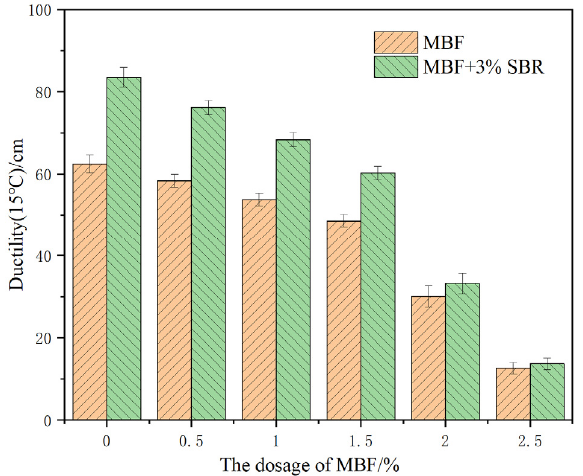
Figure 11. Effect of MBF on the 15 °C ductility of evaporation residue.